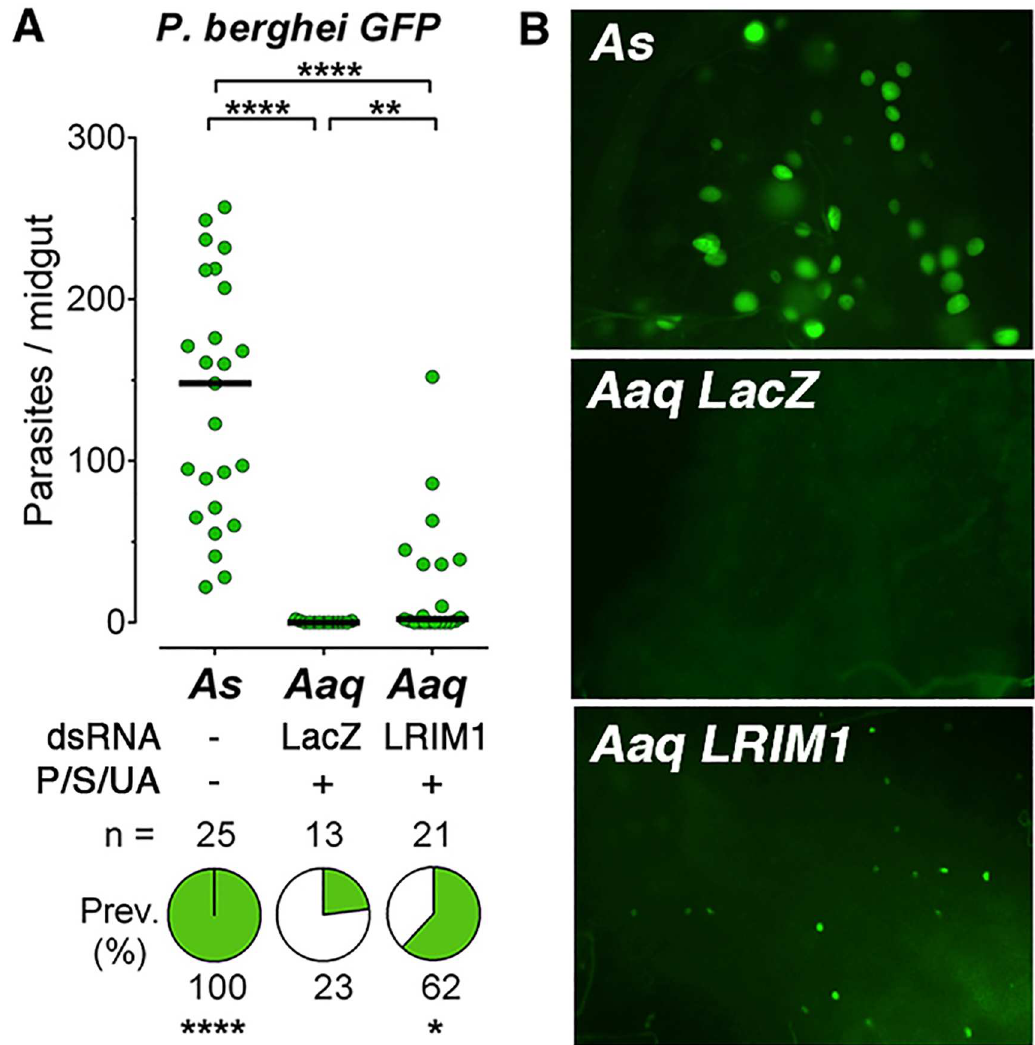
Fig 3. Infection of A . aquasalis with P . berghei . Susceptibility of Anophelesstephensi (As) and Anophelesaquasalis (Aaq) mosquitoesto infection with P . berghei .(A) Effect of disrupting the mosquitoimmune system by silencingLRIM1 on Aaq susceptibility to infection. (B) P . berghei oocysts in As and Aaq mosquitoes 8 days post infection. Each dot represents the number of oocysts present on an individual midgut 10–12 days post-infection and the median numberof oocysts is indicatedby the black line. The medians were comparedusing the Mann-Whitney test and the infection prevalence using Chi-square ( * p < 0.05, **** p < 0.0001).